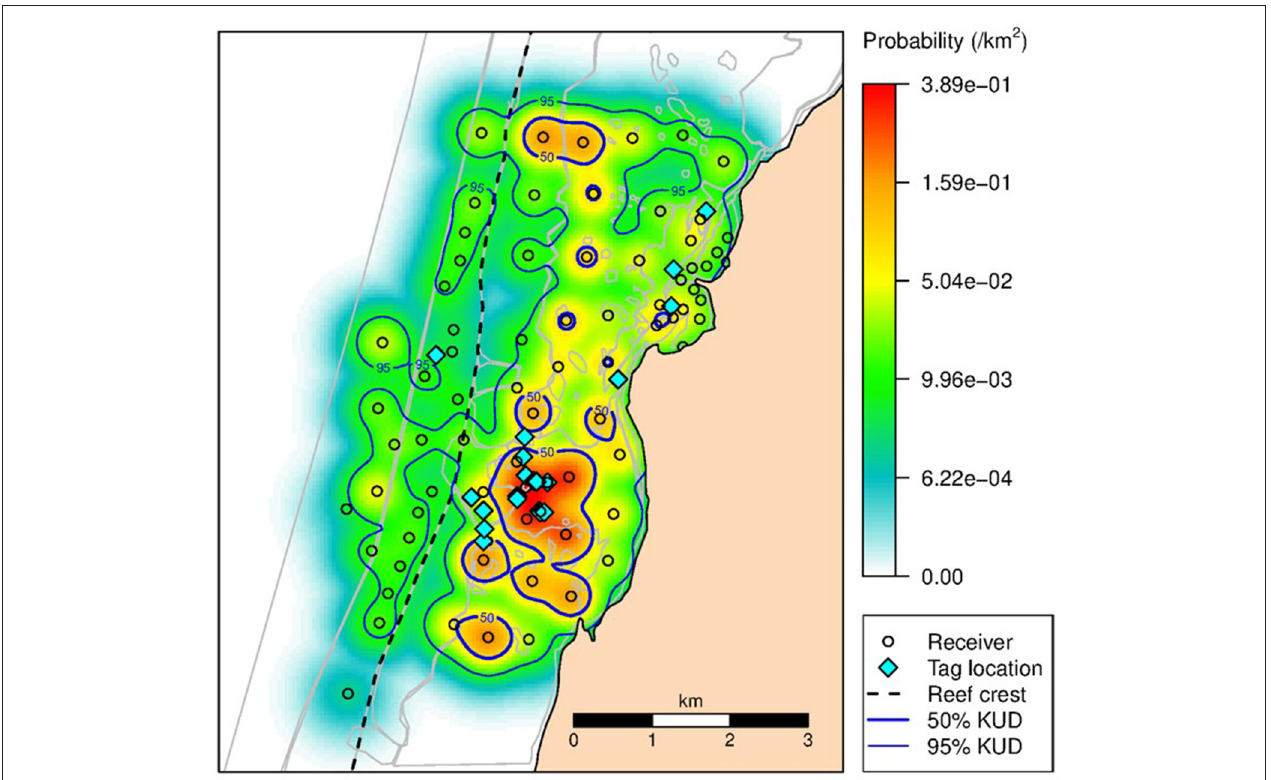
FIGURE 4 | The 50 and 95% KUD contours for all adult N. acutidens . Shading reflects the conditional probability (per km 2 ) of all tagged sharks occupying space within the array when it was within the array boundaries. Dashed line shows seaward edge of reef